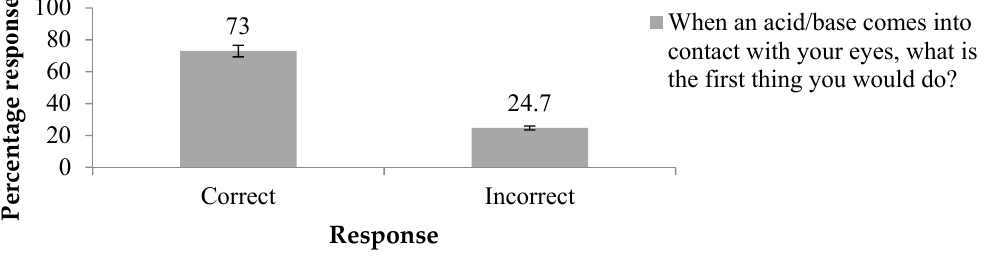
Figure 10. Percentage distribution of students’ response for the questions on Emergency Equipment and Procedures (Question 32).